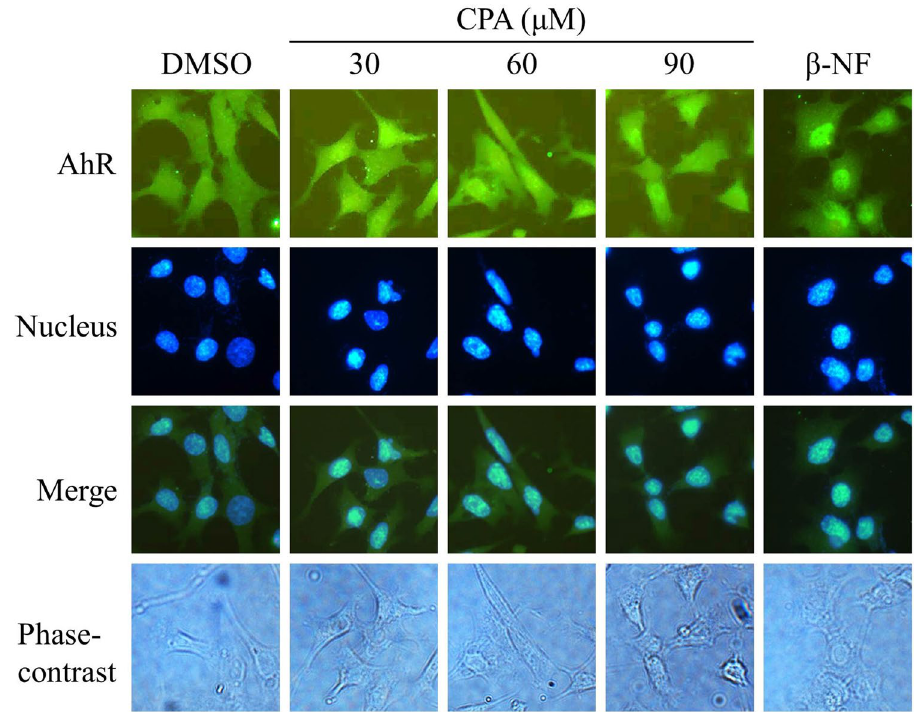
Figure 6. Induction of nuclear localization of the aryl hydrocarbon receptor (AhR) by cyproterone acetate (CPA) in mouse cells. Hepa-1c1c7 cells were treated with CPA (30, 60 and 90 μM) and β-NF (10 μM) for 2 h, and then cells were fixed with 4% formaldehyde, and nuclei were stained with Hoechst 33342 (5 μg/ml). Expression of the AhR protein was probed using an antibody against the AhR, as revealed by the fluorescence of a rabbit polyclonal secondary antibody to goat IgG-H&L (DyLight 488). Fluorescence emitted by DyLight 488 was viewed using a fluorescence microscope, equipped with optical filters at excitation/emission wavelengths of 493/518 nm. Fluorescence emitted by Hoechst 33342 was viewed using a fluorescence microscope, equipped with optical filters at excitation/emission wavelengths of 346/460 nm. Fluorescence images for the AhR and nucleus were